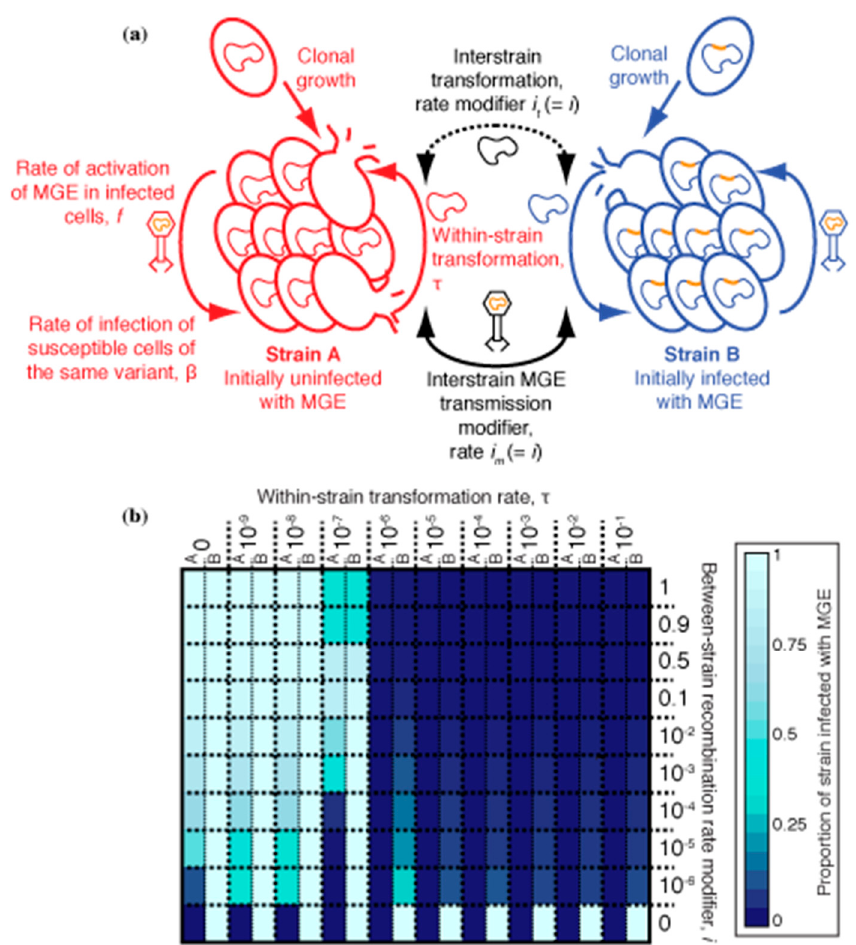
Figure 4. Simulations of sequence exchange between co-colonising S. pneumoniae strains. ( a ) Structure of the model. Two distinct strains co-colonise a single host. There is no interconversion between them. Both behave identically when they have the same MGE infection status. Strain A is initially completely uninfected, whereas strain B is uniformly infected. Sequence exchange within each strain is unimpeded. However, interstrain exchange is limited by a factor, i , which applies equally to both recombination through transformation ( i t ) and MGE transmission ( i m ). ( b ) Heatmap showing the results of simulations. The properties of the MGE, MV, were constant across simulations, with variation in transformation rate ( τ ) shown across columns, and variation in i shown across rows. Each cell is split in two, with the halves showing the proportion of cells infected with an MGE in strains A (left) and B (right). Differences between the cell halves represent impeded MGE transmission between the strains. The displayed values are calculated as the mean across three replicate simulations.